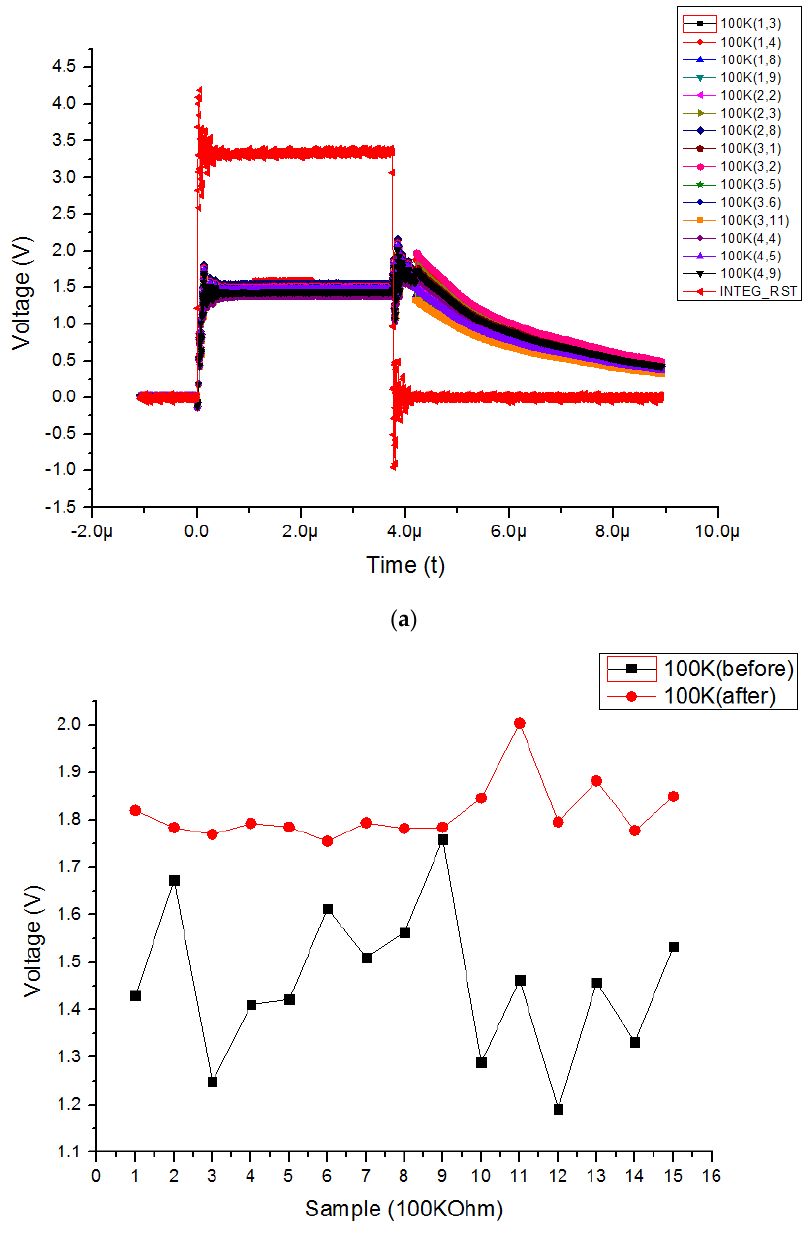
Figure 7. (a) The 100 k Ω active pixel output voltage according to integrator reset voltage before calibration (b) experimental results before and after applying proposed adjustment technique to the 100 k Ω active pixel.